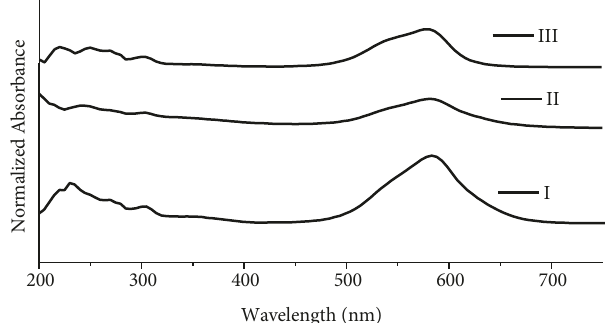
Figure 1: UV/Vis spectra for groups I, II, and III of blue ballpoint pen inks.